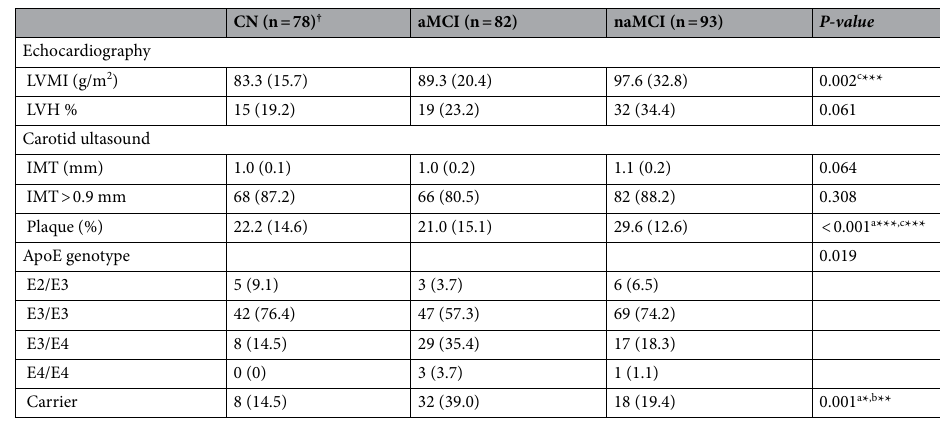
Table 2. Peripheral vascular burden and ApoE genotypes in the study groups. Continuous variables expressed as mean (standard deviation), categorical variables expressed as n (%). Kruskall-Wallis test for continuous variables. Chi-squared or Fisher’s exact test for categorical variables. Pairwise comparisons with Bonferroni corrections. CN, cognitively normal (controls); aMCI, amnestic mild cognitive impairment; naMCI, non- amnestic mild cognitive impairment; LVMI, left ventricular mass index; LVH, left ventricular hypertrophy; IMT, intima-media thickness; Carrier, carrying at least one E4 allele. † ApoE genotyping available for n = 55. a Significant difference between aMCI and naMCI, b Significant difference between aMCI and CN, c Significant difference between naMCI and CN, *** P ≤ 0.001, ** P < 0.01, * P < 0.05.